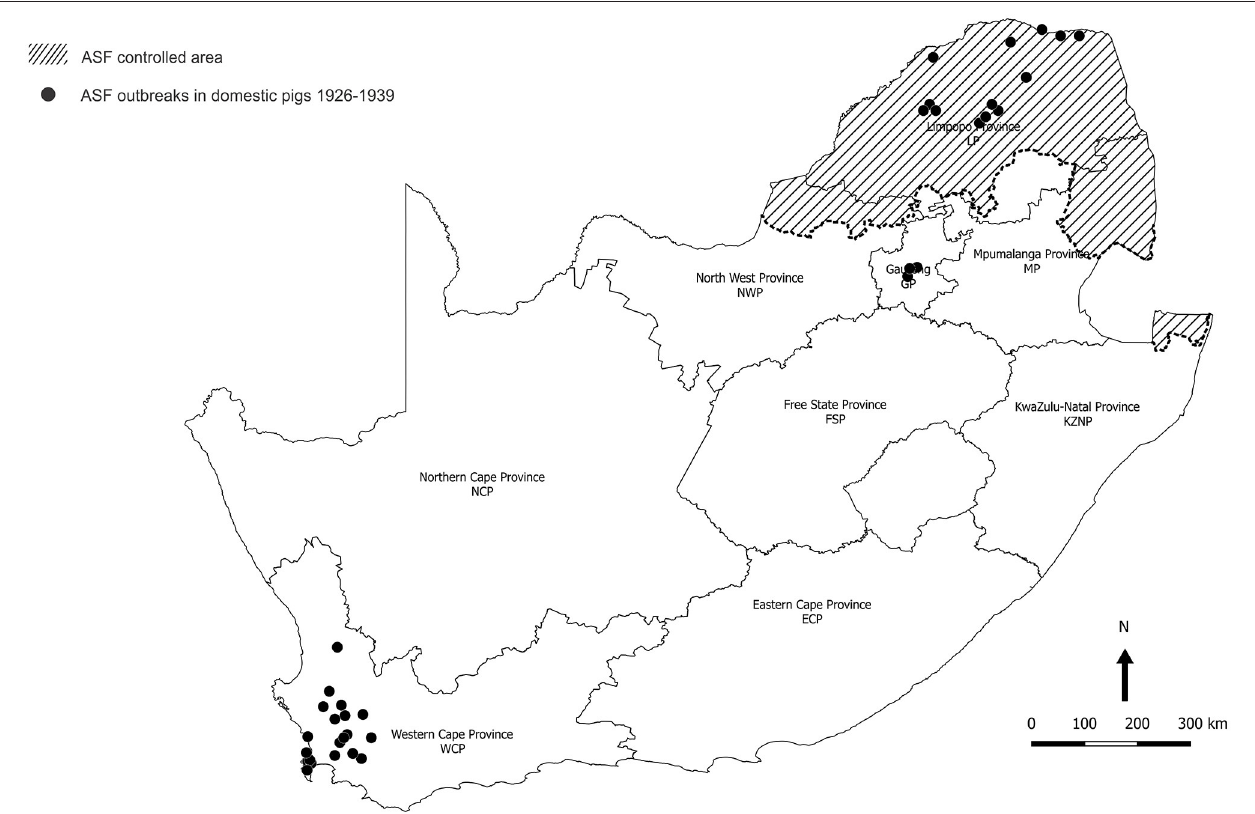
FIGURE 1 | Distribution of 37 outbreaks of African swine fever in South Africa, 1926–1939, for which approximate coordinates (correct to 0.1 degree) were derived from references cited in the text. The South African Protection of Personal Information Act 4 of 2013 precludes divulging names and accurate coordinates of private